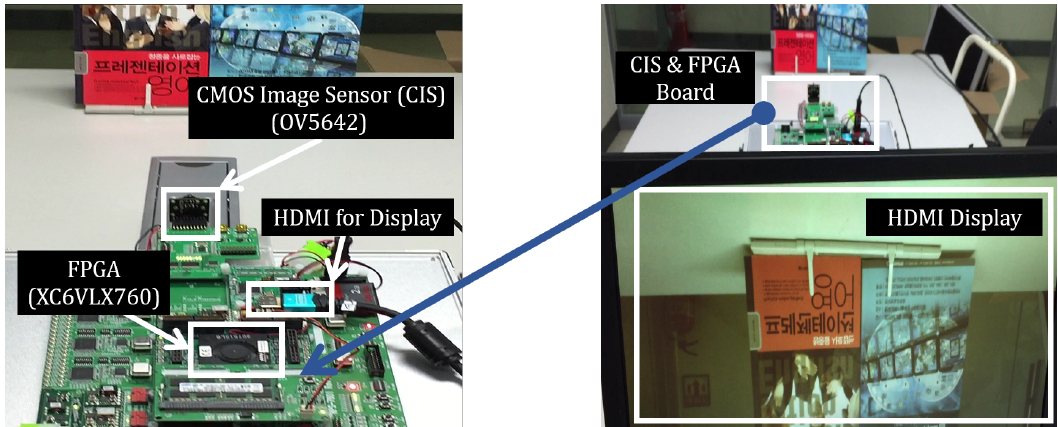
Figure 8. System configuration for integrating the implemented VLSI design of the proposed filter with CMOS image